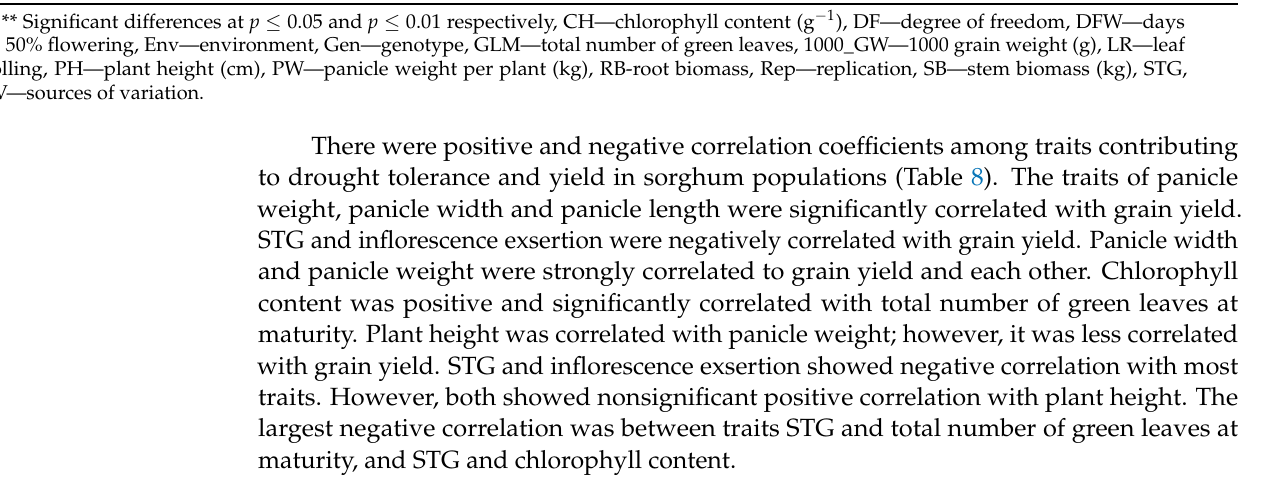
Table 8. Correlation coefficients of traits contributing to drought tolerance and grain yield of sorghum genotypes under well-watered and water-stressed